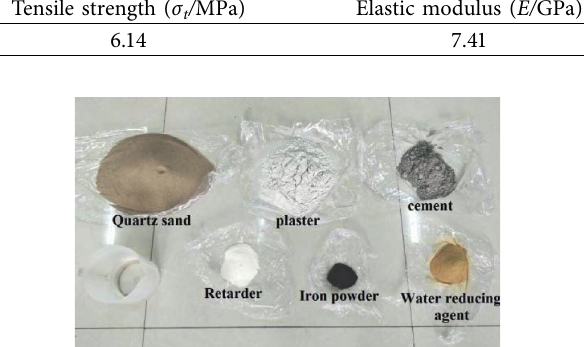
Figure 1: Similar material model of the test material covered by the